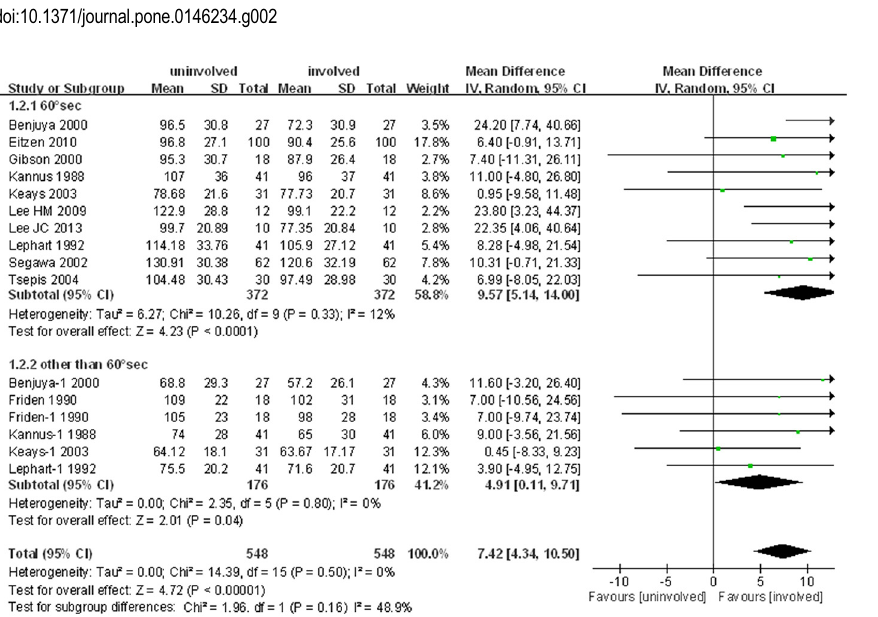
Fig 3. Forest plot showing significant reductions in hamstring strength in ACL deficient compared with uninjured